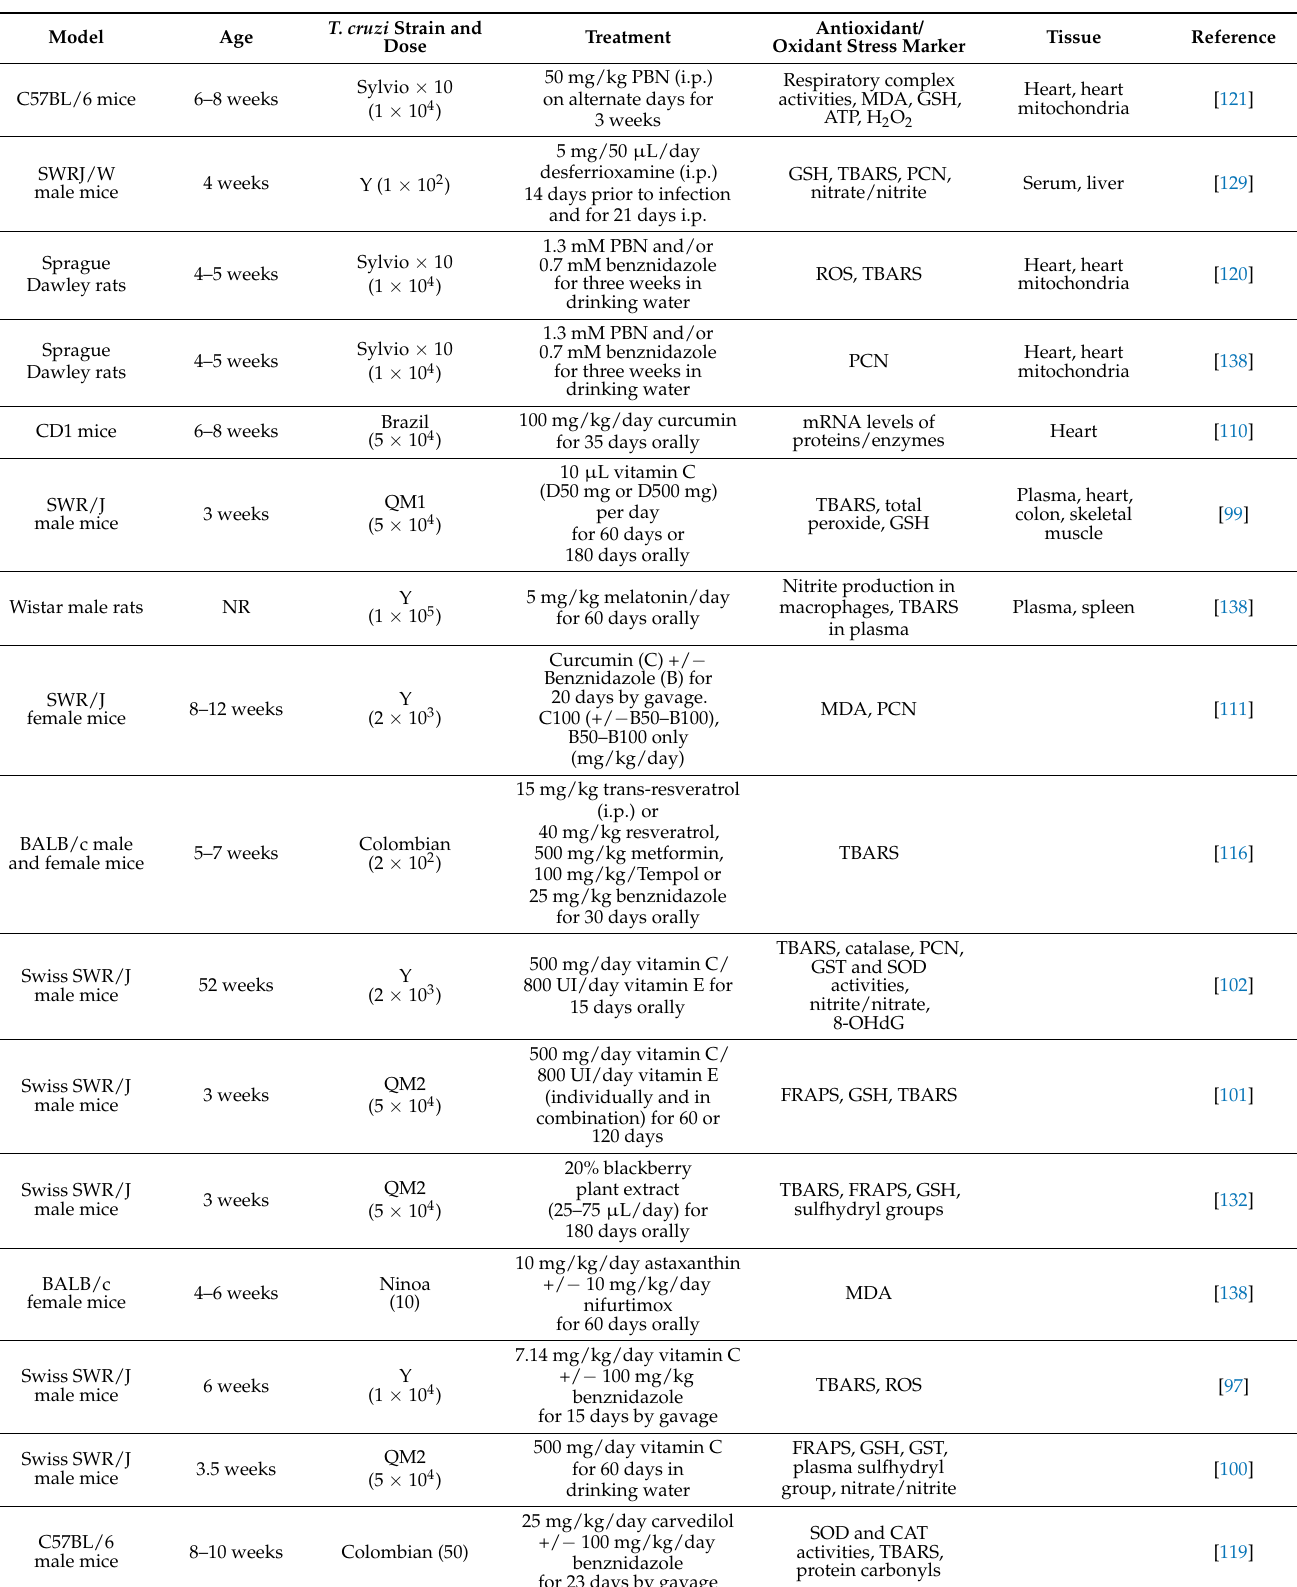
Table 3. Antioxidant treatment in Chagasic animal